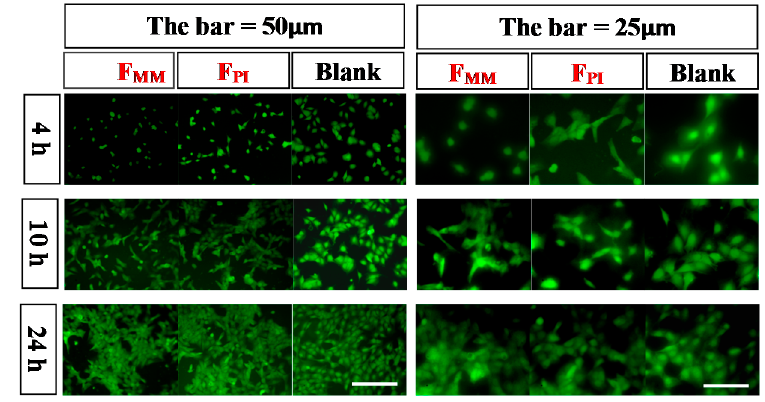
Figure 5. Cell adhesion on different substrates for 4, 10, and 24 h.